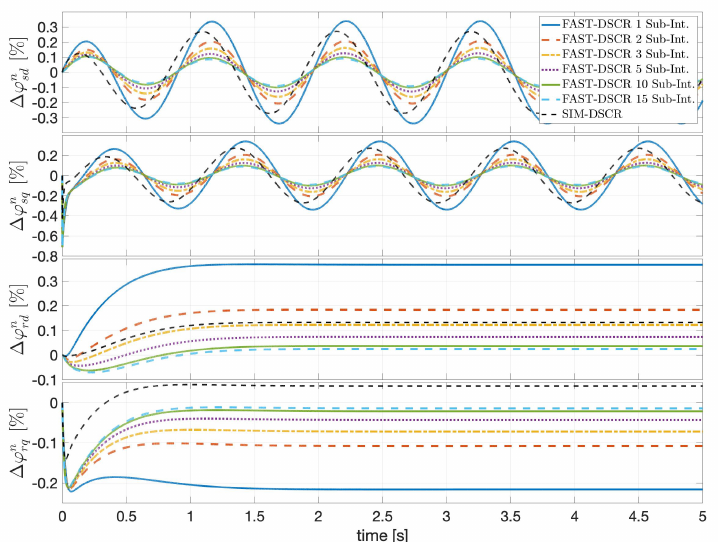
Figure 12. Percentage difference between CNT and FAST-DSCR at low frequency increasing the integration sub-intervals for flux estimation in (from top to bottom) stator d -axis, stator q -axis, rotor d -axis, rotor q -axis. Stator field and rotor mechanical rotational speed equal to 6 rad